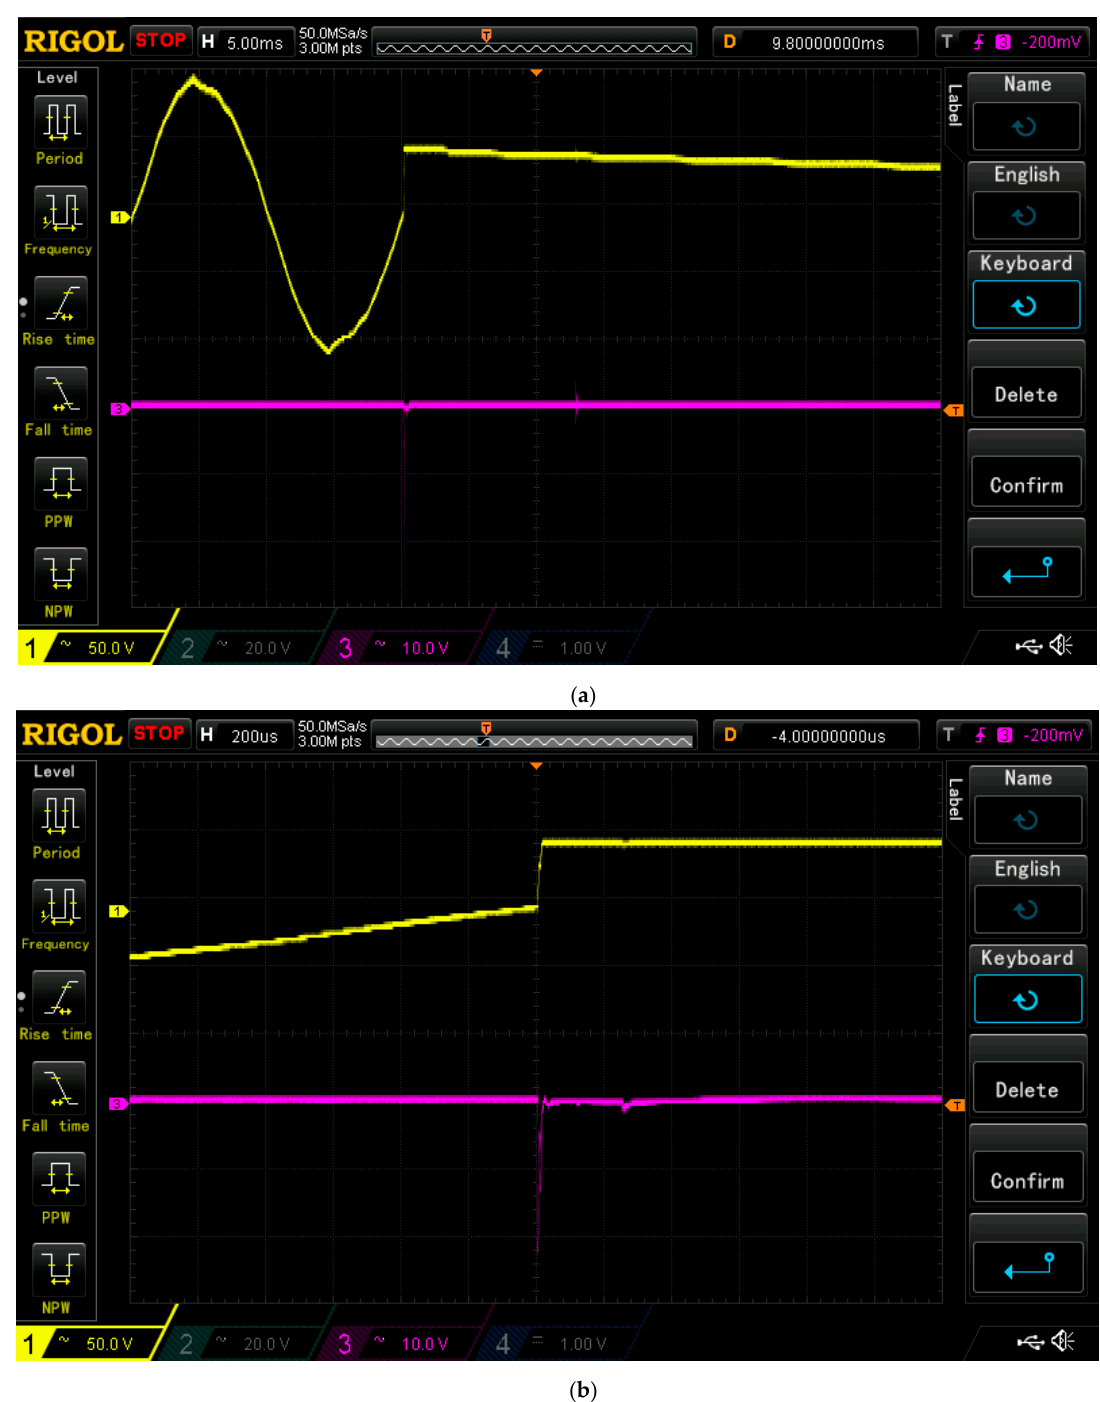
Figure 10. Figure of fault phase ( a ) and enlarged view ( b ) . ψ =